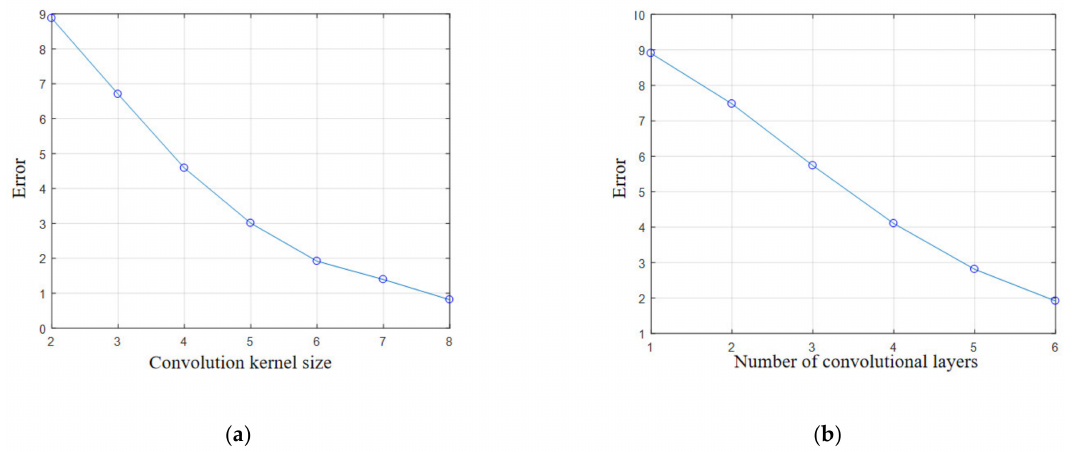
Figure 11. Influence of the number of convolution layers and the size of convolution kernel on model error. ( a ) The influence of the size of the convolution kernel, ( b ) the number of convolutional layers on the model error.